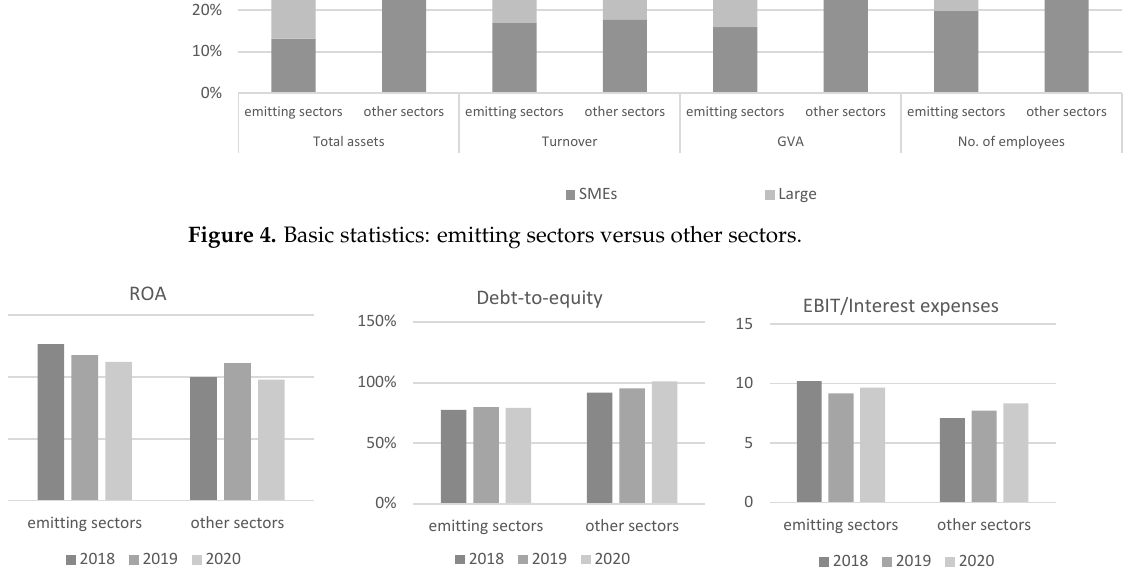
Figure 4. Basic statistics: emitting sectors versus other sectors.